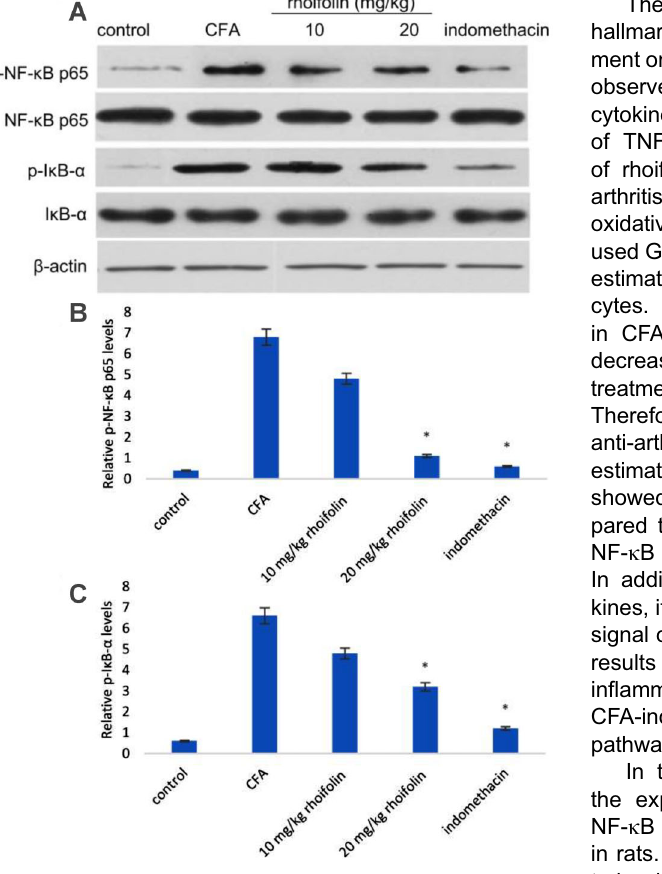
Figure 5. Western blot analysis of levels of phosphorylated and non-phosphorylated forms of NF- k B p65 and I k B- a with b -actin used as a control ( A ). Western blot densitometry anal- ysis of phosphorylated NF- k B p65 ( B ) and phosphorylated I k B- a ( C ). Data are reported as means ± SE. *P p 0.05 com- pared to complete Freund ’ s adjuvant (CFA)-induced group